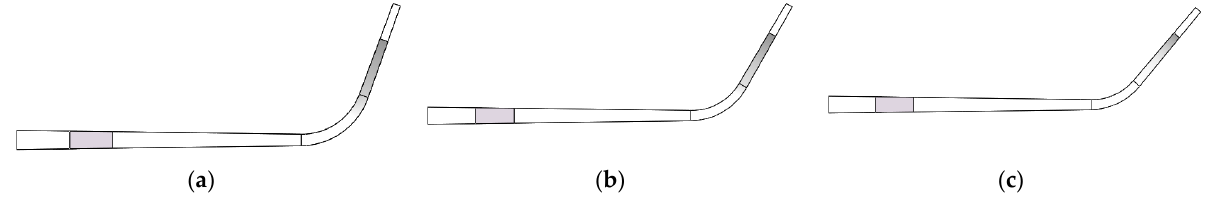
Figure 4. Rotary tiller with different bending-angle models. ( a ) bending angle of 110°; ( b ) bending angle of 120°; ( c ) bending angle of 130°.